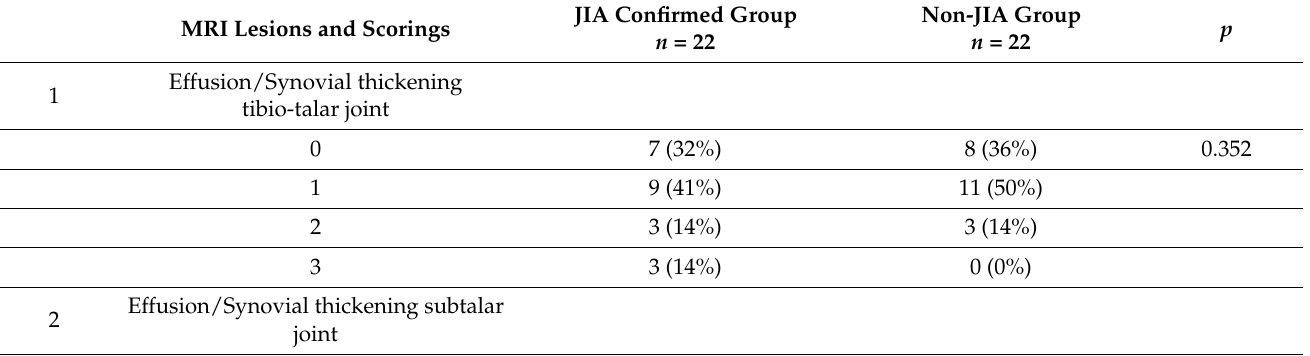
Table 3. MRI results in JIA vs. non-JIA